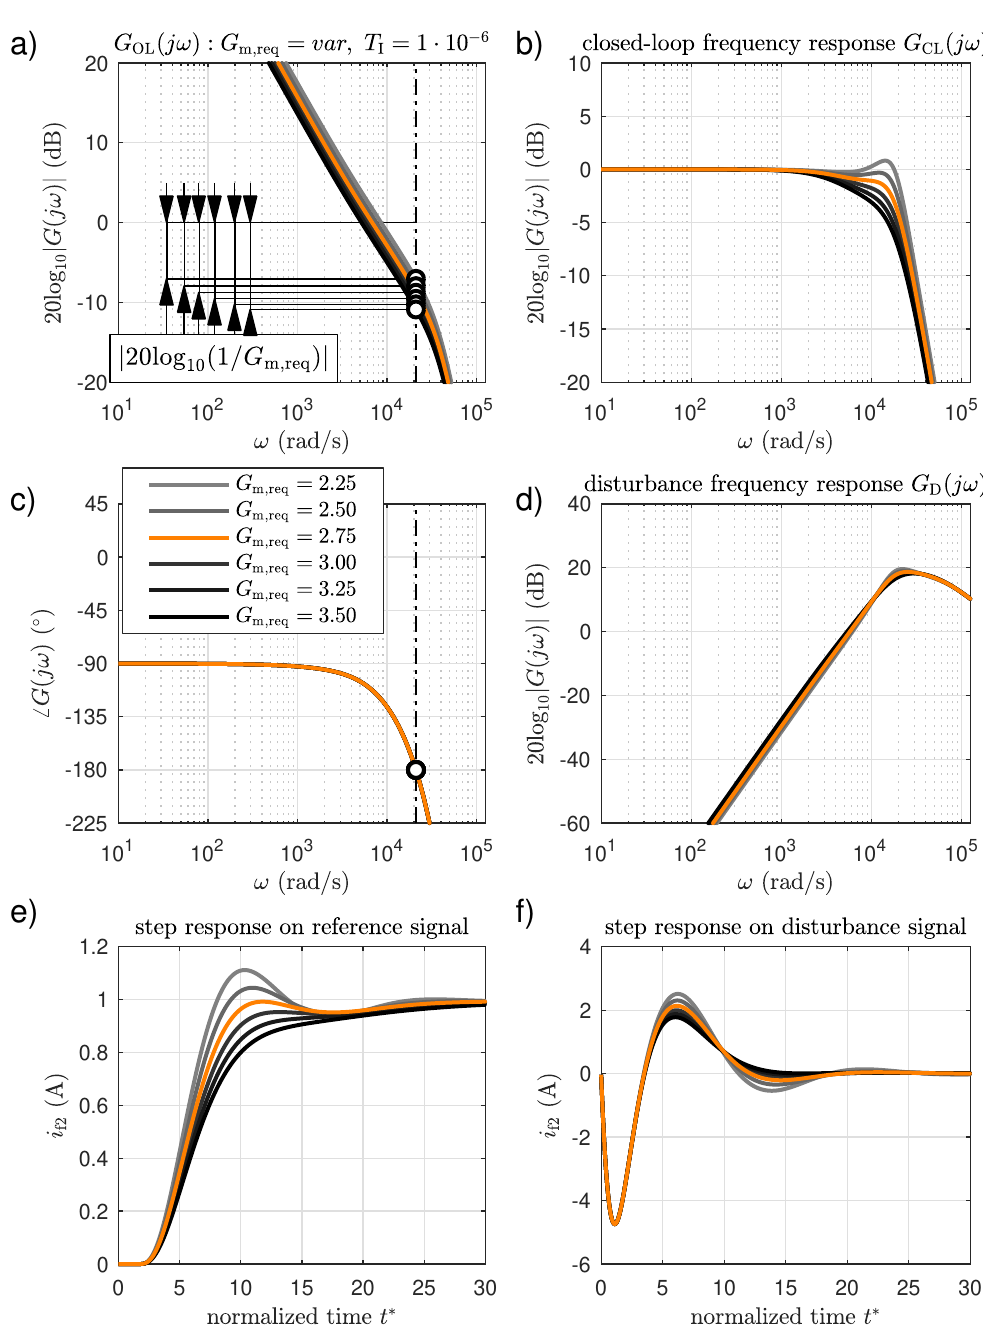
Figure 7. The current control loop characteristics at constant integral time of T I = 1.0 × 10 − 6 and for various gain margin G m,req values: ( a , c ) amplitude and phase Bode plots of the open-loop system frequency response, ( b ) amplitude Bode plot of the closed-loop system frequency response, ( d ) amplitude Bode plot of the disturbance frequency response of the system, ( e ) response of the system on a unit step of the reference signal, ( f ) response of the system on a unit step of the disturbance